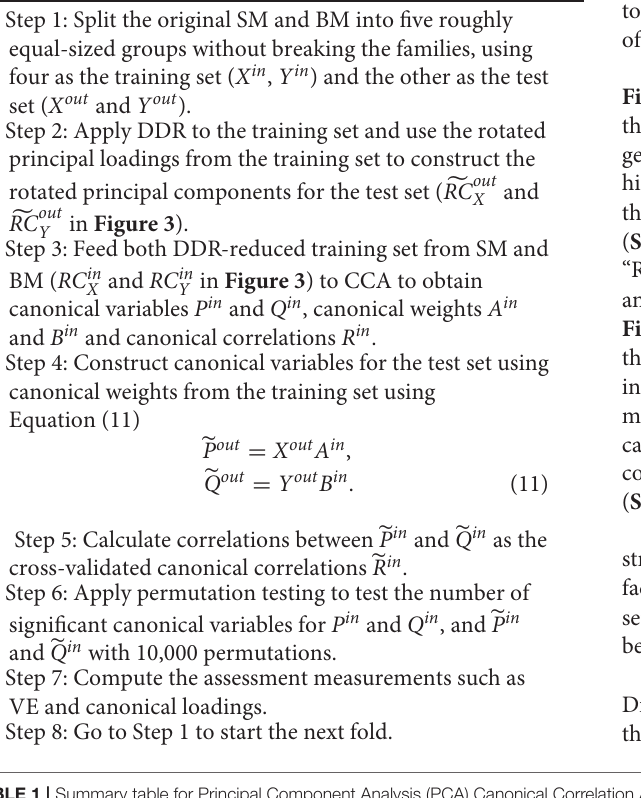
Algorithm 1 | Cross-validation procedure for the DDR CCA analysis